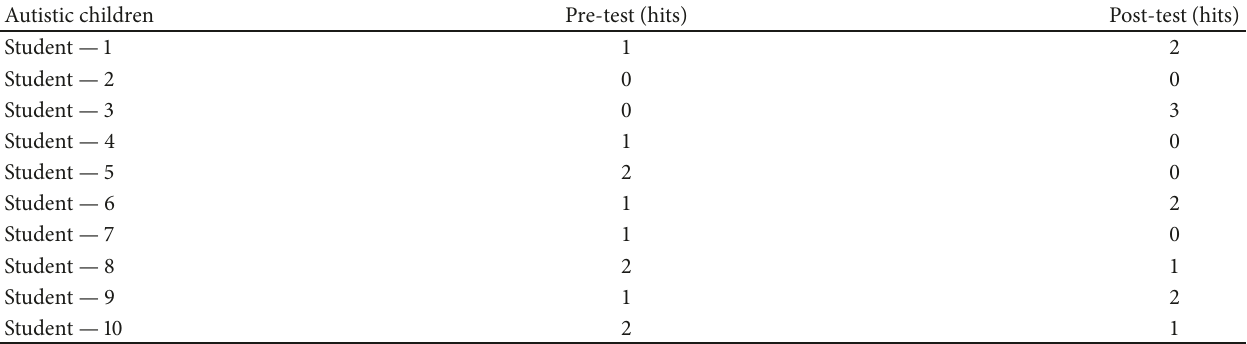
Table 3: Summary of correct answers for children with ASD when they used the QuizEmotion application in the pre- and posttest. Autistic